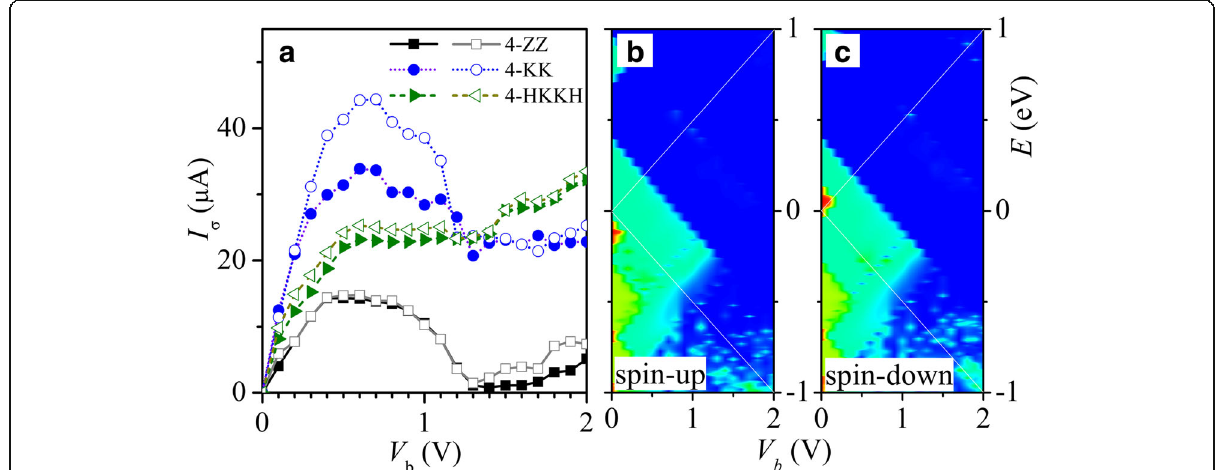
Fig. 6 a The spin-up (filled) and spin-down (empty) I - V characteristics of 4-ZZ (square), 4-KK (circle), and 4-HKKH (triangle) InSe nanoribbons are pre- sented. The corresponding transmission spectra of spin-up ( b ) and spin-down ( c ) are shown for the 4-ZZ nanoribbon. The transport window between μ μ L and R is marked by the white